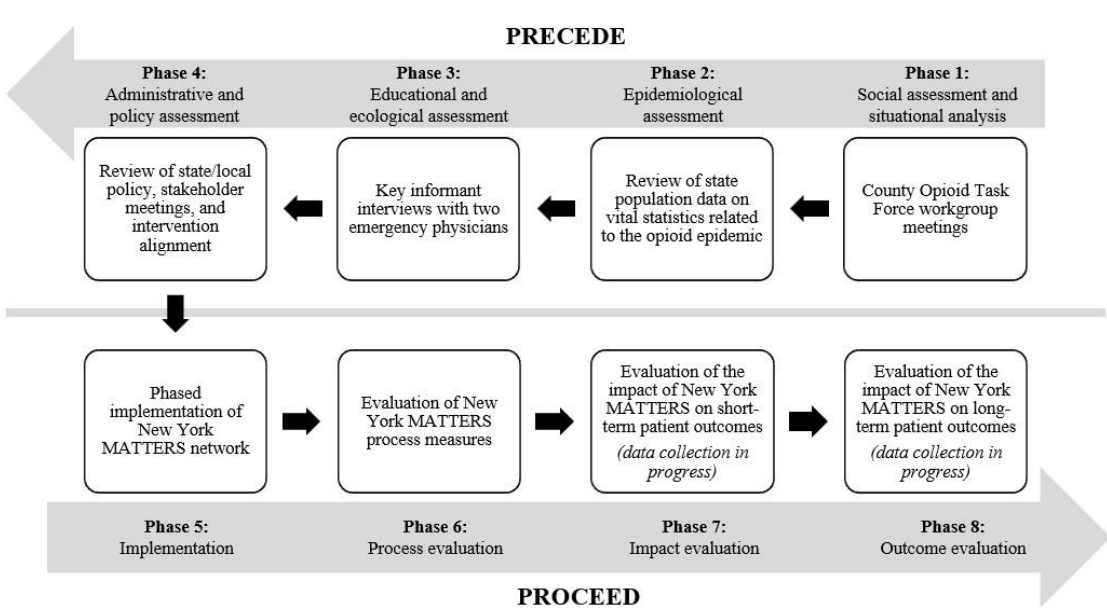
Figure 1. Adapted PRECEDE-PROCEED framework. MATTERS , Medication Treatment and Electronic Referrals